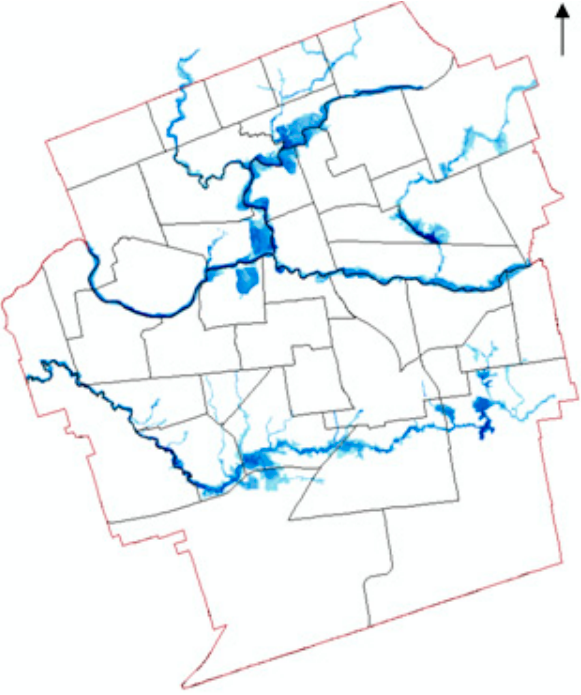
Figure 12. Map of the extent of projected flood inundation of the Thames River (north) and Dingman Creek (south) within the municipal boundary of the City of London [22].